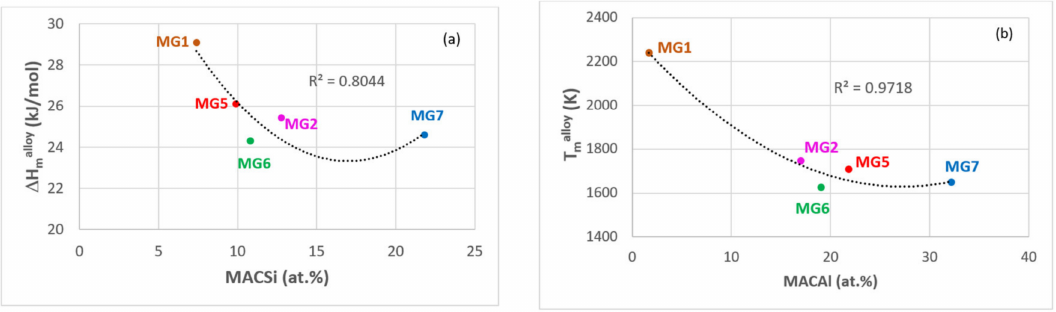
Figure 14. Relationships between the parameter ( a ) ∆ H malloy versus MACSi and ( b ) T malloy versus MACAl.